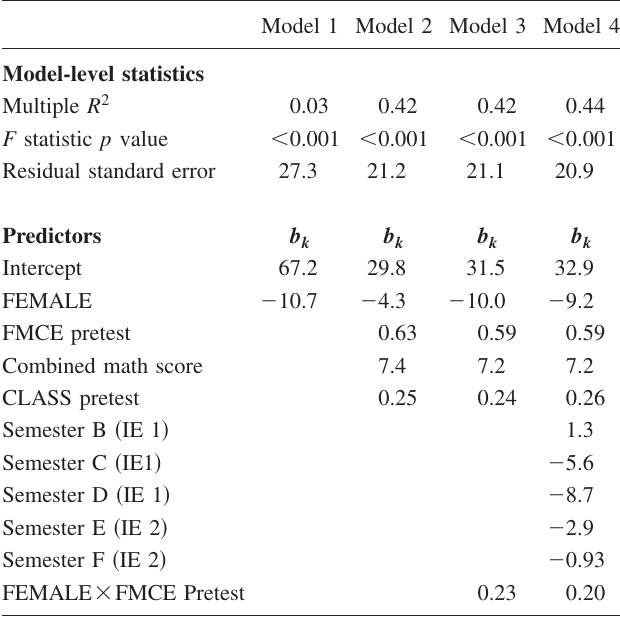
TABLE VIII. Coefficient estimates and multiple regression model statistics for each multiple-regression